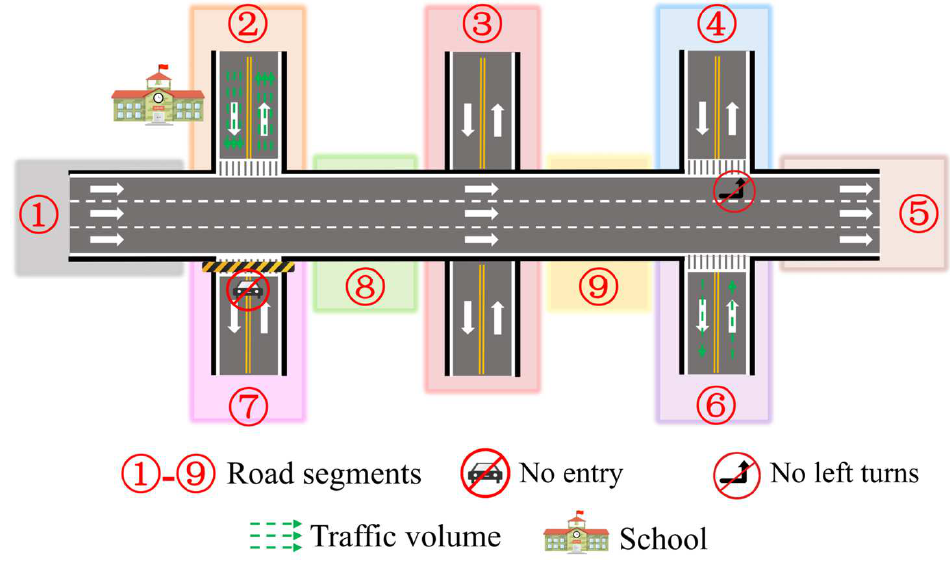
Figure 2. Example of a real-world road network with complex traffic dependency and traffic prop- erties.